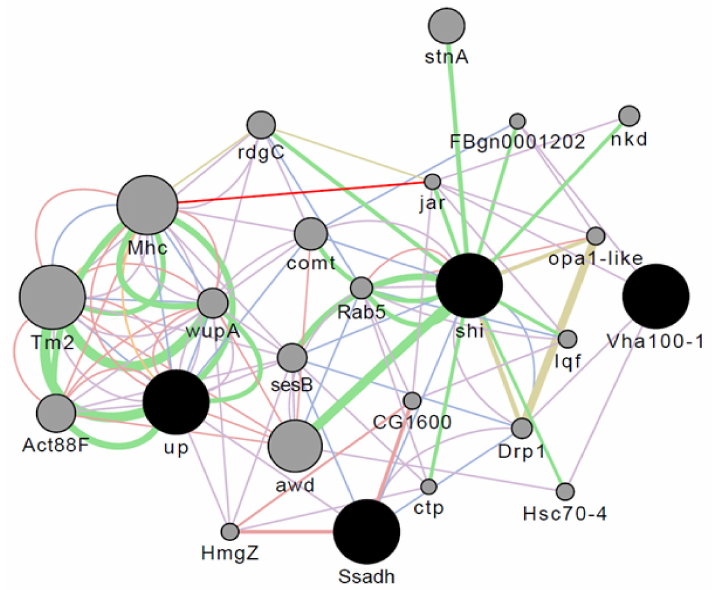
Figure 2. Composite network of multiple regulation of the GABA/5-HTP-treated group with dif- ferentially expressed genes that satisfied |fold change| ≥ 2. The black circles are downregulated genes, and 11 most related genes and 20 most related attributes are shown. The source networks are grouped by type network weight, as well as the sum of the weight of the networks in the